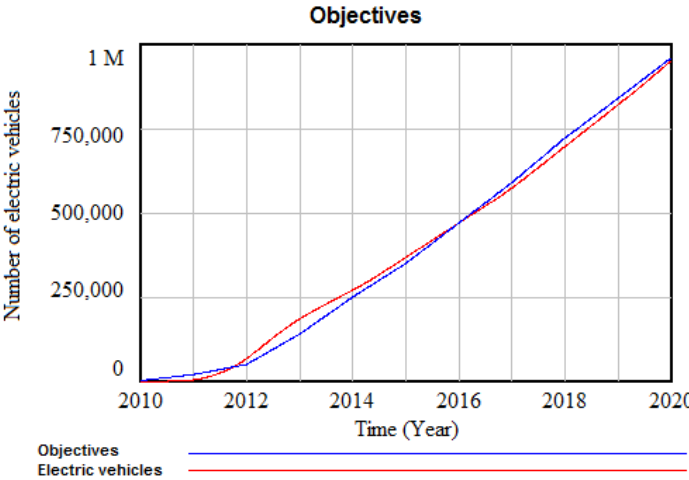
Figure 16. Electric vehicle fleet compared to the Government target for the optimistic scenario with optimal subsidies until 2020 (the authors’